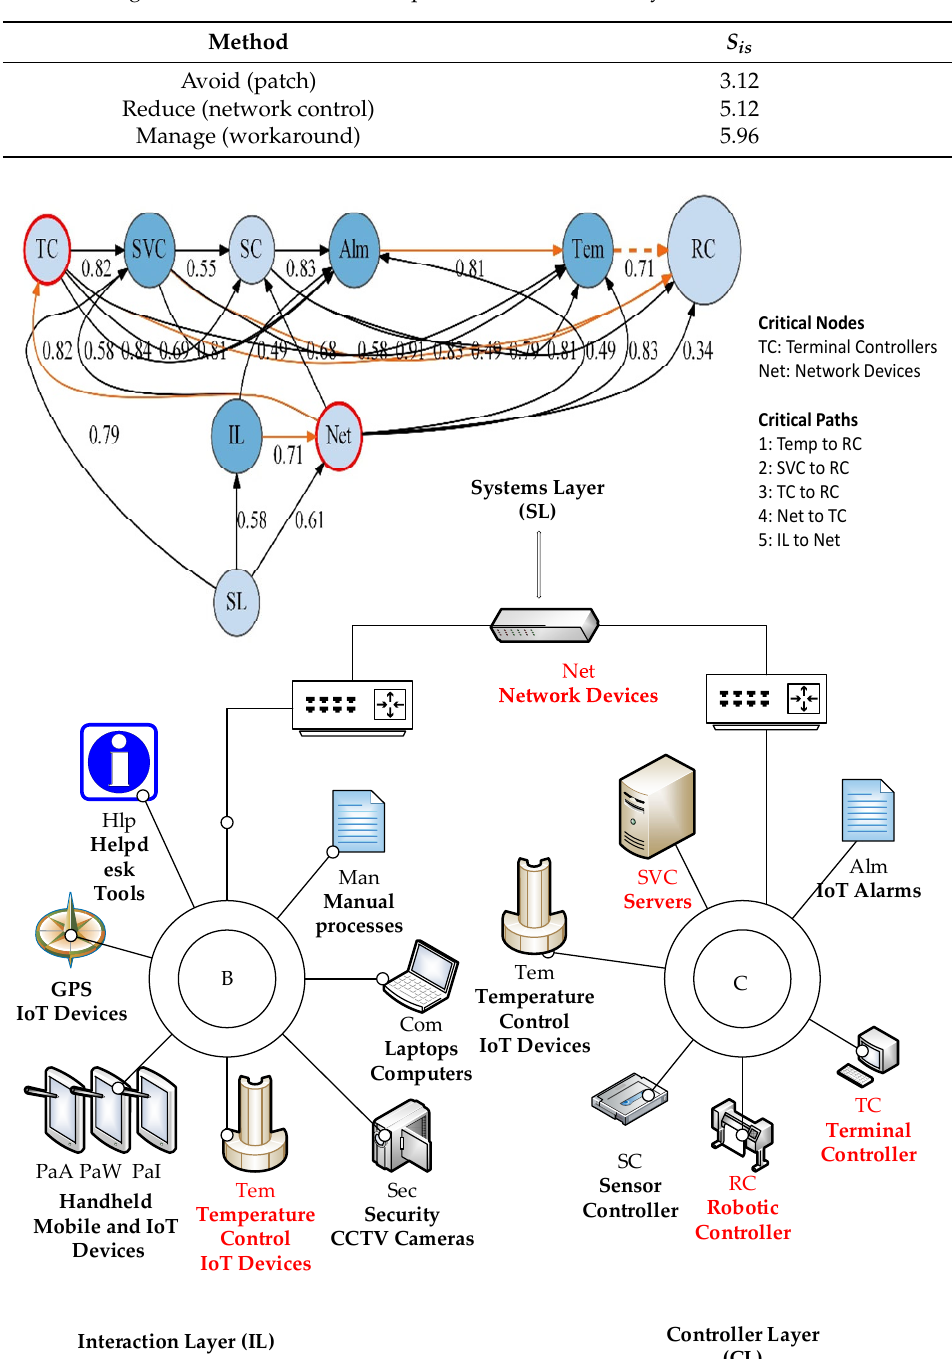
Table 1. Mitigation methods and their impact scores for case study 1.